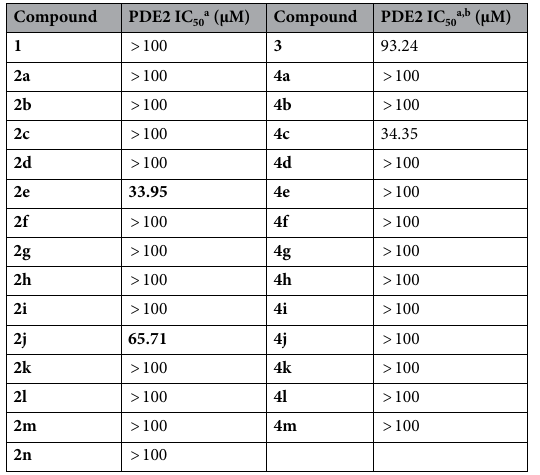
Table 2. In vitro PDE2 inhibitory activity of 6 H -benzo[ c ]chromen-6-one derivatives 2 and 4 . a BAY60-7550 was used as the reference compound with an IC 50 of 8.4 nM. b Results are expressed as the mean of at least three experiments. Significant values are in bold.